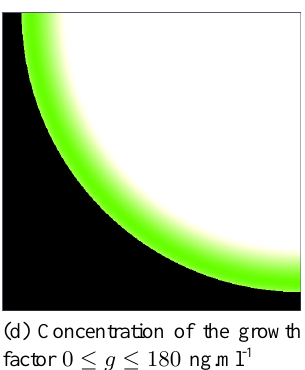
Fig. 4: Bone matrix density, concentrations of stem cells, osteoblasts and the growth factor at t = 3